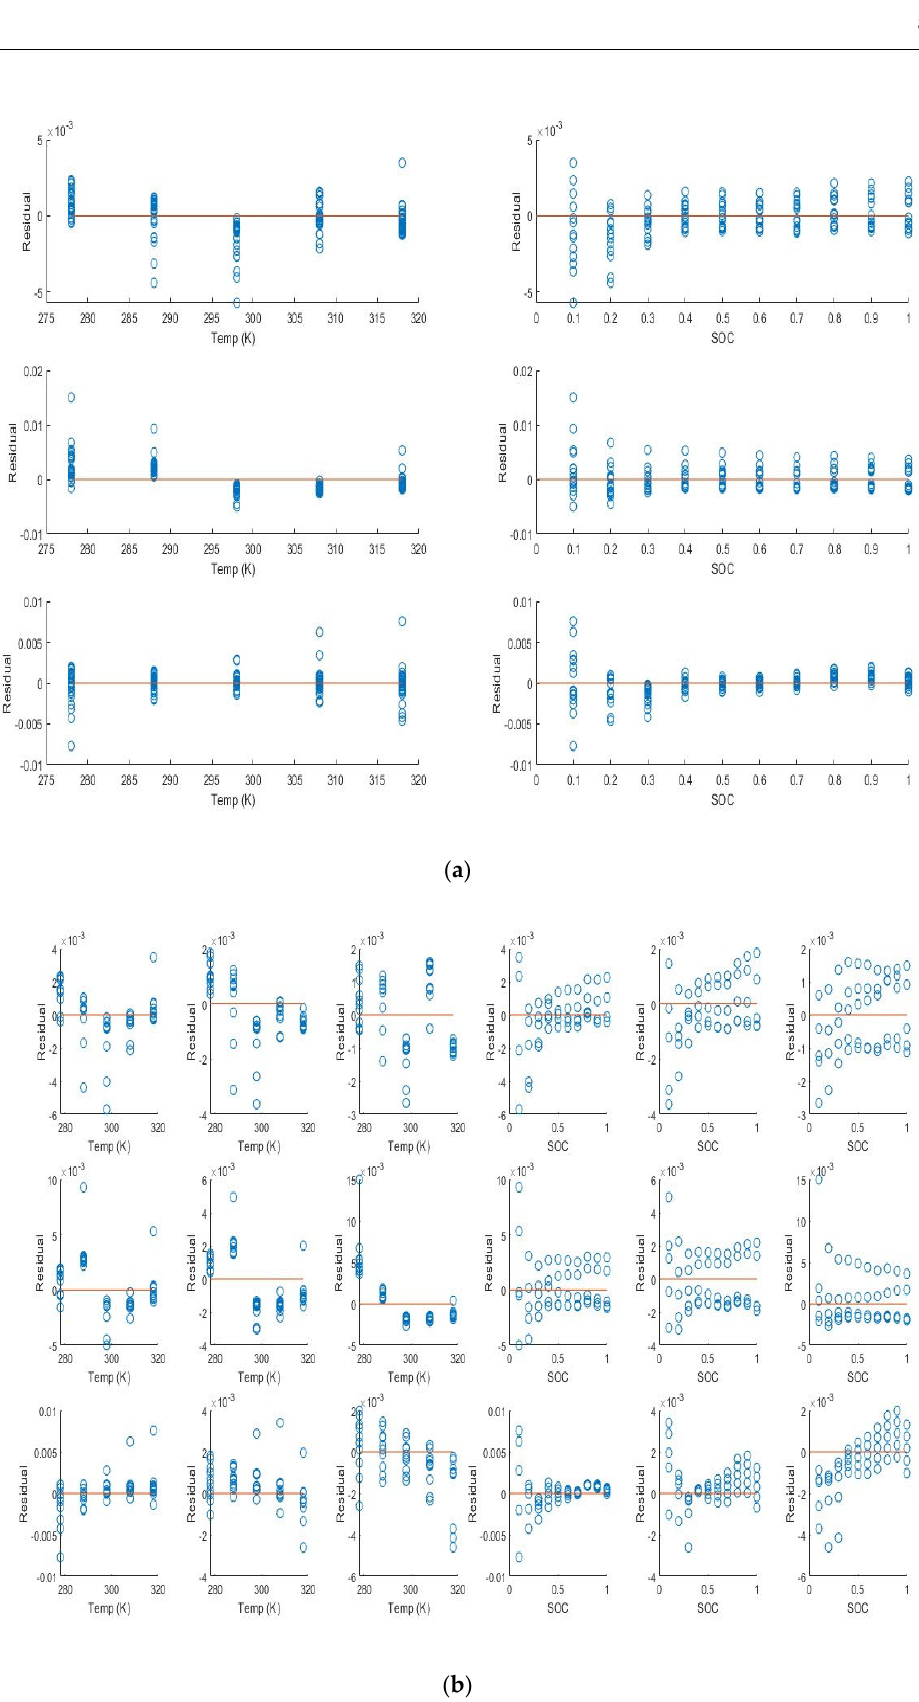
Figure 4. ( a ) Residual plot of Internal Impedance modeled from Equation (3) with residuals plotted against Temperature and SOC ( b ) Residual plot of Internal Impedance modeled from Equation (3) with residuals plotted against Temperature and SOC with each C-rate on a separate